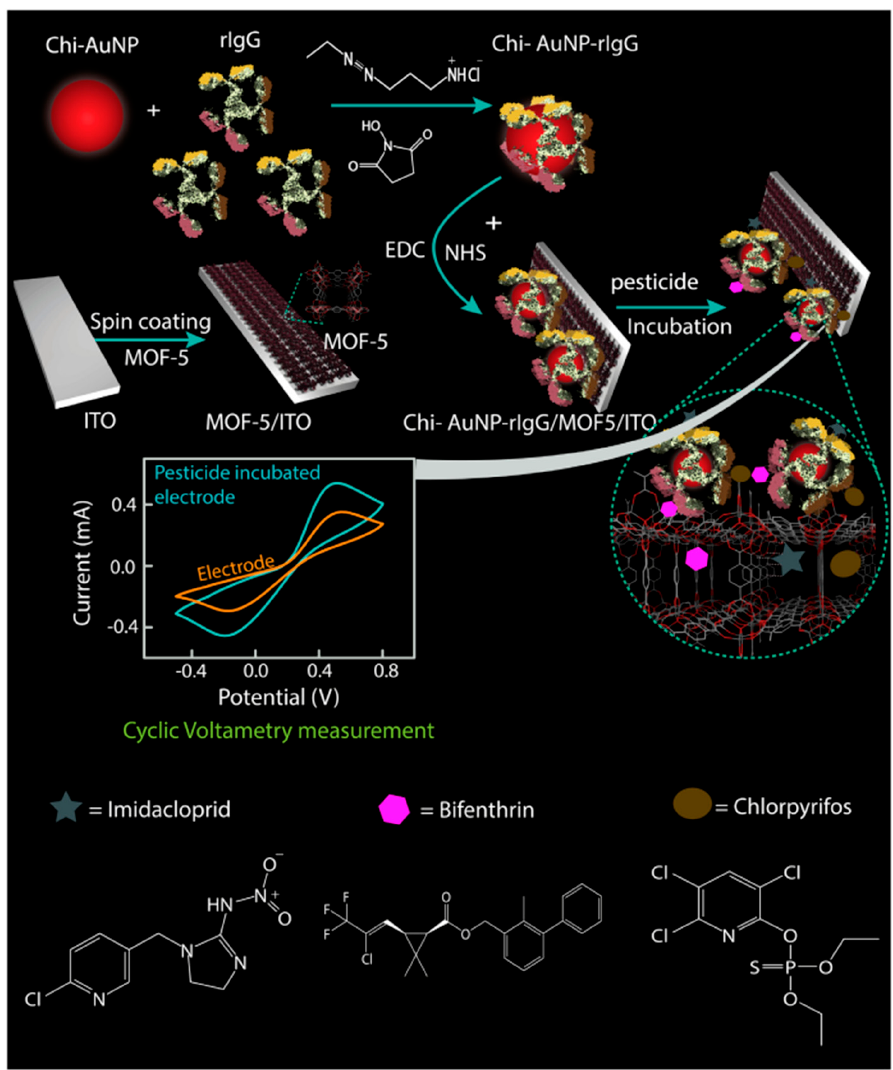
Figure 4. Schematic representation of the mechanism of fabrication and detection of pesticides by immunoelectrode ([66]).